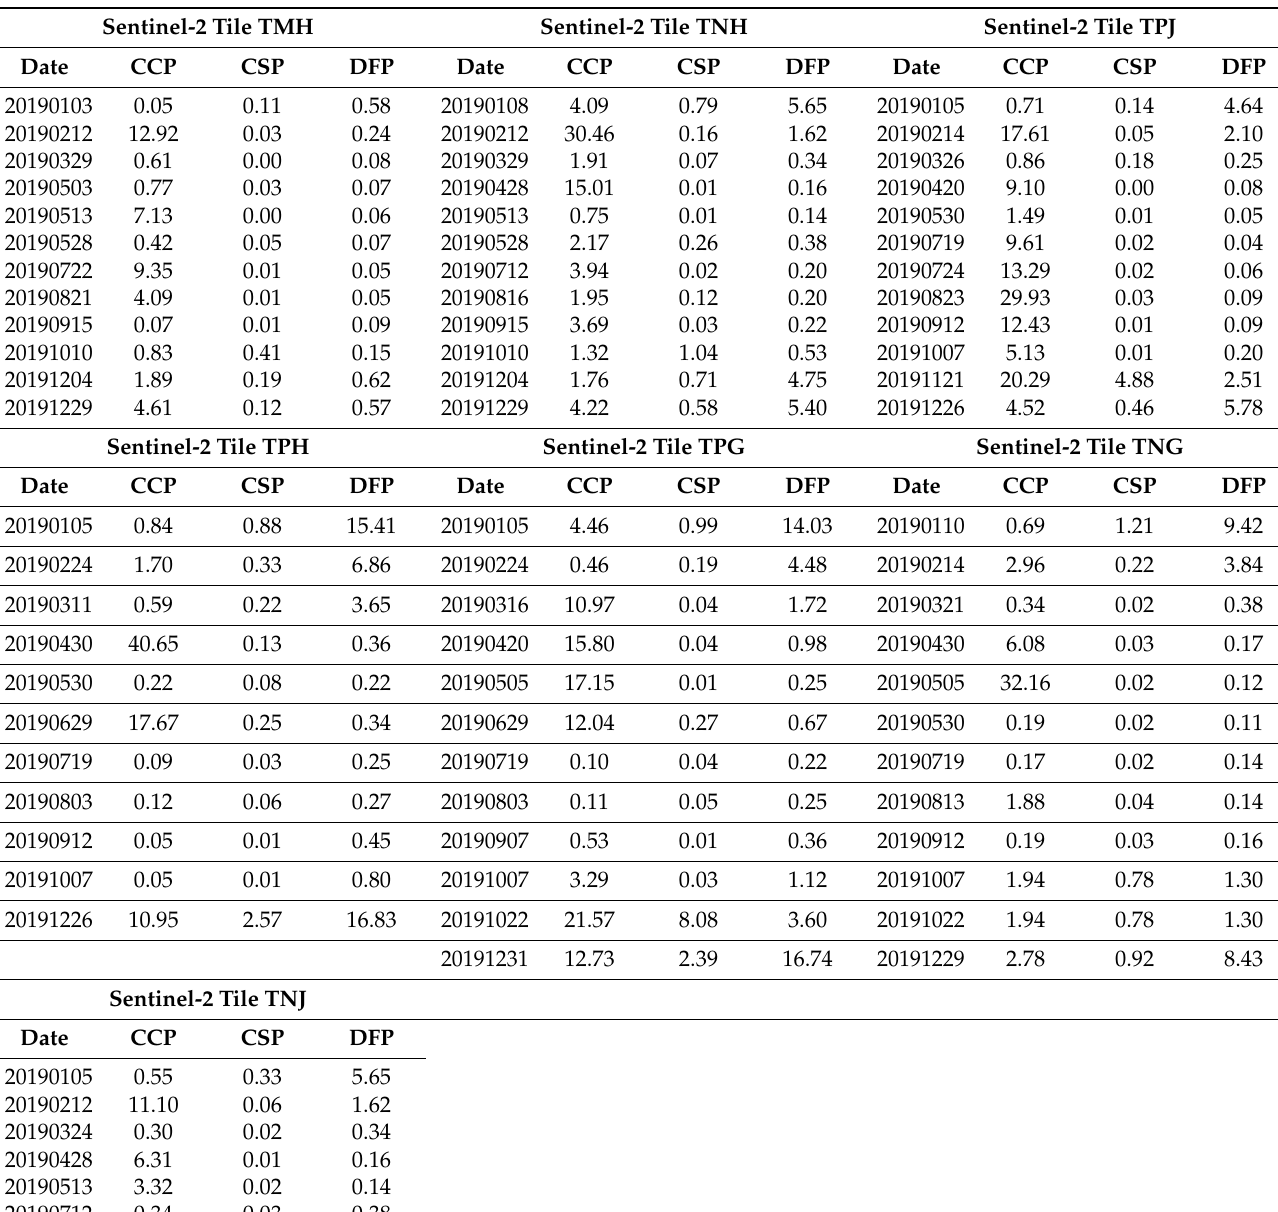
Table 2. Sentinel-2 images downloaded and used for land cover map creation. Images are grouped according to their tiles and their acquisition dates. The cloud cover percentage (CCP), cloud shadow percentage (CSP) and dark features percentage (DFP) are listed for each